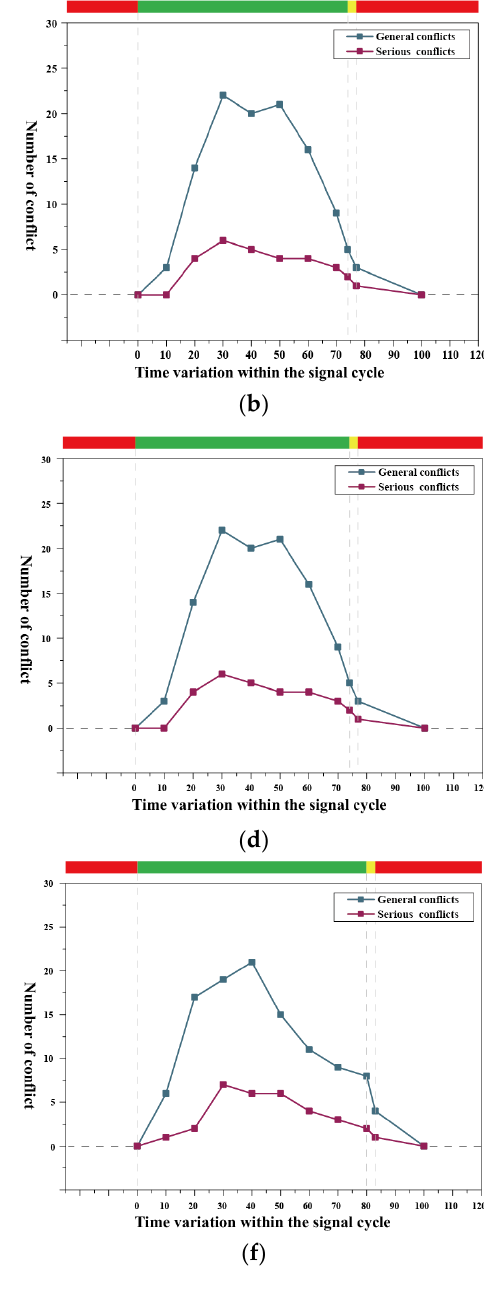
Figure 12. The distribution of two conflict types during one signal cycle period. ( a ) Distribution of Conflict Type 1 (Zhuque); ( b ) Distribution of Conflict Type 2 (Zhuque); ( c ) Distribution of Conflict Type 1 (Hanguang); ( d ) Distribution of Conflict Type 2 (Hanguang); ( e ) Distribution of Conflict Type 1 (Chenyangzhai); ( f ) Distribution of Conflict Type 2 (Chenyangzhai).